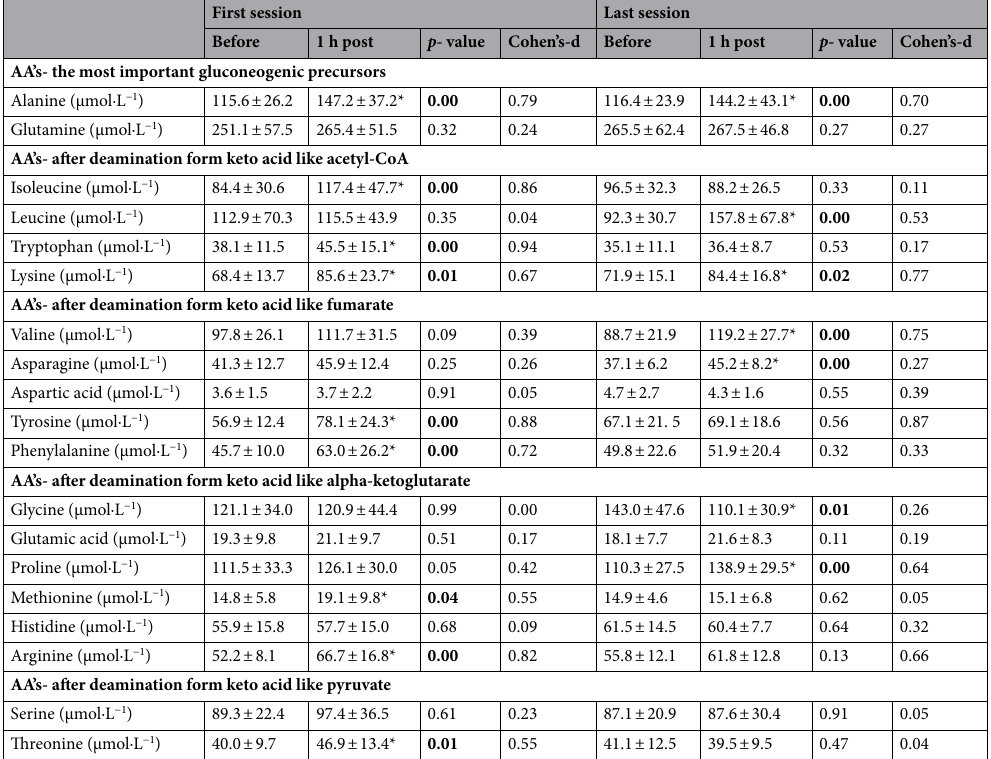
Table 2. The effect of single session of the whole-body cryotherapy on amino acid profile. Data are presented as mean ± SD; AAs- amino acids; *statistically significant difference (before vs 1 h); Statistically significant differences are bold; Cohen’s d- effect size: > 0.2 small, > 0.5-medium, >